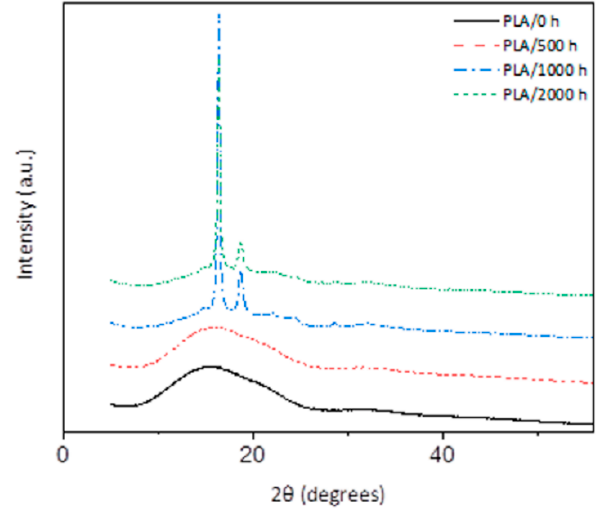
ff raction spectra of neat PLA at di ff erent accelerated weathering times. Figure 5. X-ray diffraction spectra of neat PLA at different accelerated weathering times. Figure 5. X-ray di